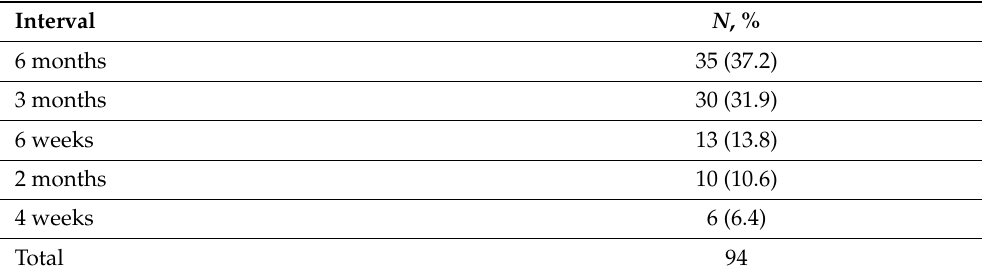
Table 7. Interval for appendectomy after conservatively management of appendicular mass.